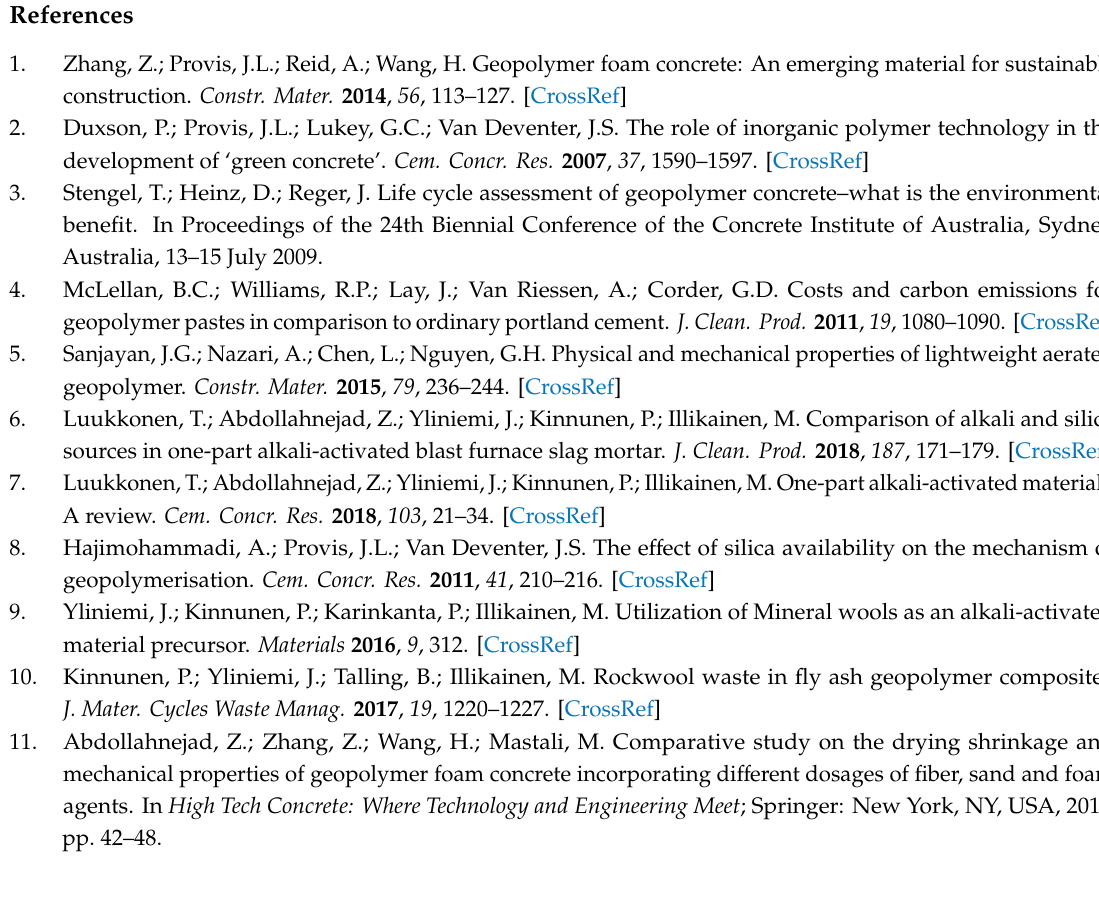
Before After Before After